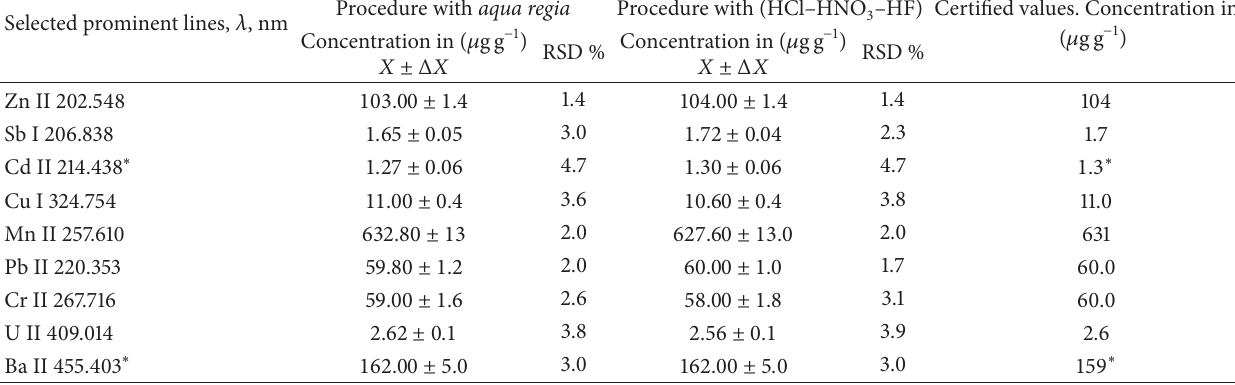
Table 4: Content of Zn, Sb, Cd, Cu, Mn, Pb, Cr, U, and Ba (in 𝜇 g g − 1 ) obtained by JY ULTIMA 2 in the analysis certified reference material –HF) [28] (column 5): mean values 𝑋 for ( 𝑛 = 4 IAEA/Soil 7 by both procedures with aqua regia [27] (column 2) and with (HCl–HNO 3 replicates) and the confidence interval of the mean value Δ𝑋 for statistical confidence 𝑃 = 95 % and 𝑓 = 𝑛 − 1 = 3 (columns 2 and 4) and relative standard deviations (RSD %) (columns 3 and 5), and certified values (column 6). –HF) Certified values. Concentration in Procedure with aqua regia Procedure with (HCl–HNO 3 Selected prominent lines, 𝜆 , nm